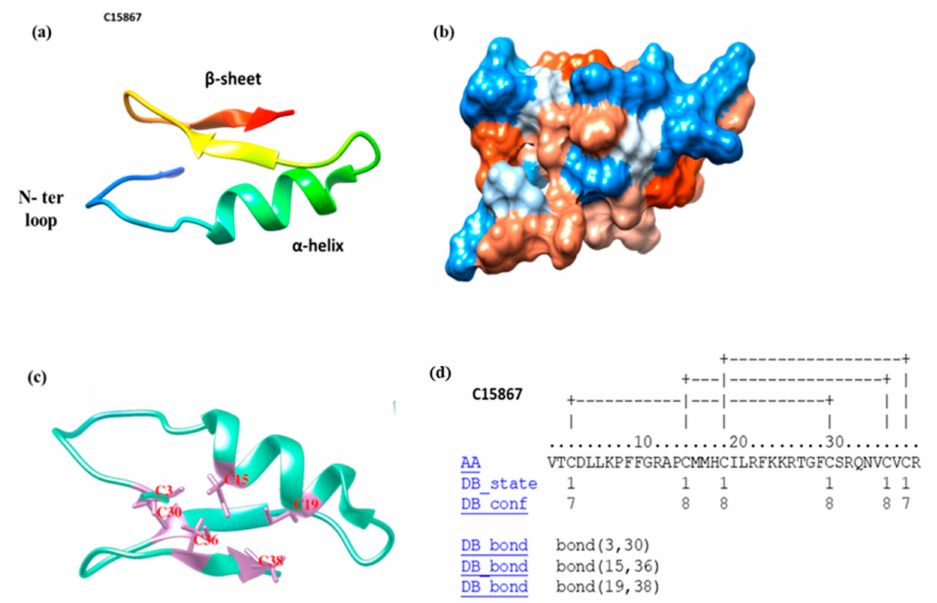
Figure 1. ( a ) C-15867 ribbon model: the N-ter loop, the α -helix region and the C-ter β -sheet are shown in different colors; ( b ) hydrophobicity surface of the C-15867 peptide. Hydrophobic residues are in orange-red while hydrophilic residues are highlighted in blue. The figure was generated with UCSF CHIMERA software [45]; ( c ) Cys3, Cys15, Cys19, Cys30, Cys36, Cys38 residues present in C-15867 peptide; ( d ) disulfide bonds pattern of C15867 predicted through the DISULFIND server. The figure was generated with UCSF CHIMERA software